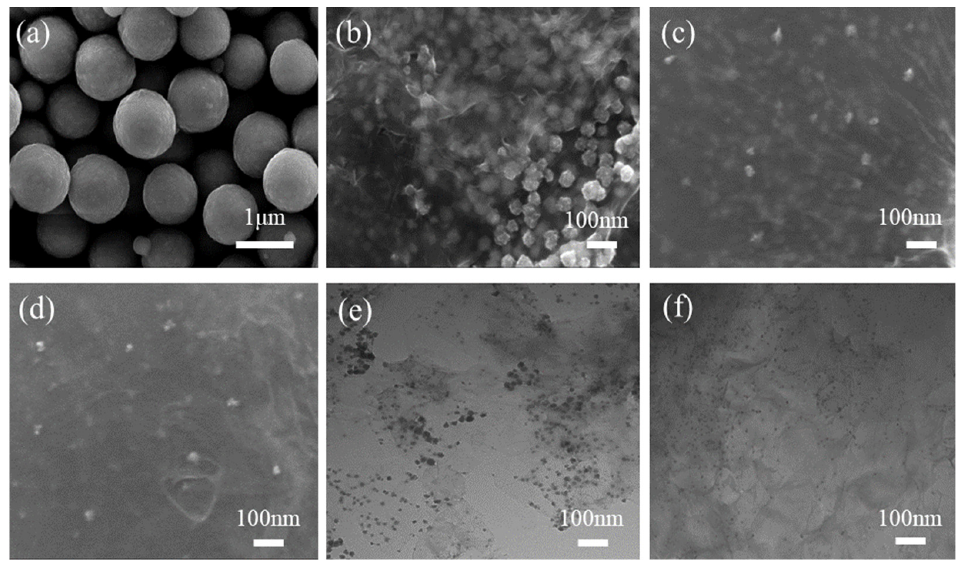
Figure 3. SEM images of Sb 2 S 3 ( a ) and the Sb 2 S 3 /RGO composites G2 ( b ), G3 ( c ), G4 ( d ); TEM images of composites G2 ( e ) and G3 ( f ).